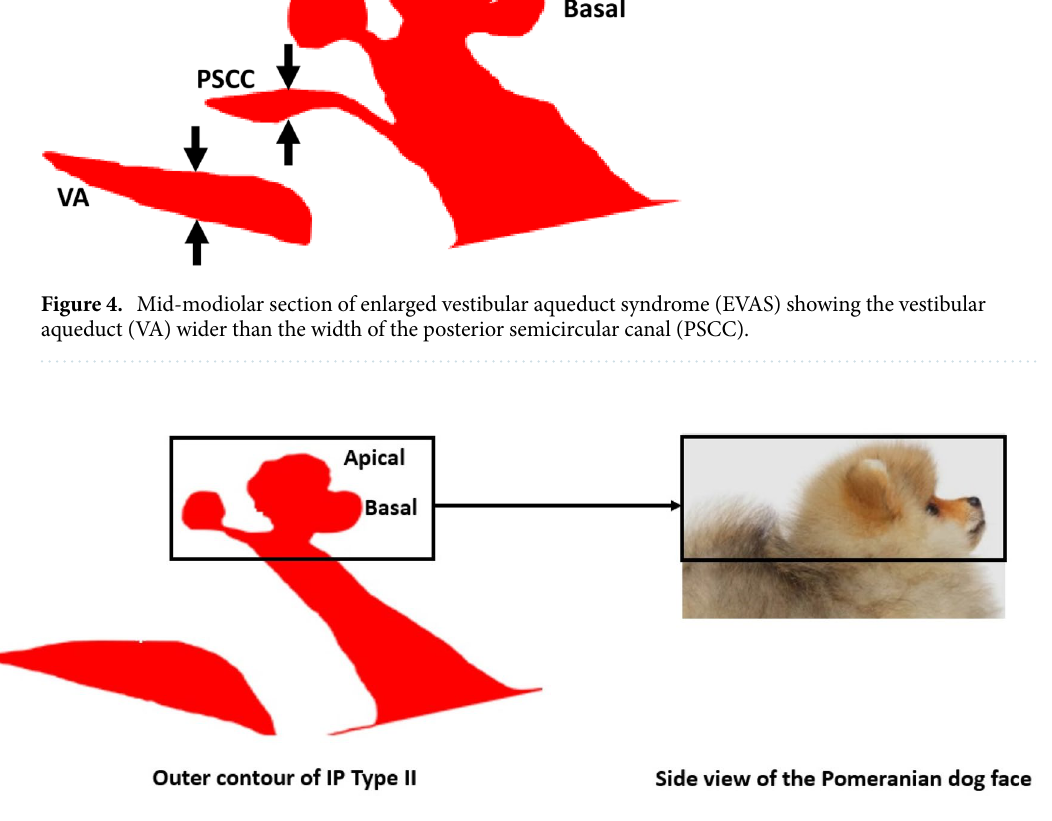
Figure 5. Mid-modiolar section of the cochlear portion of incomplete partition (IP) type II resembles the side view of a Pomeranian dog’s face. Images are not to